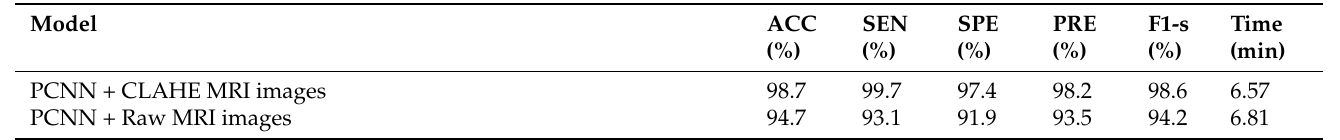
Table 3. Performance evaluation of the proposed parallelistic convolution neural network using the raw MRI and pre-processed CLAHE MRI